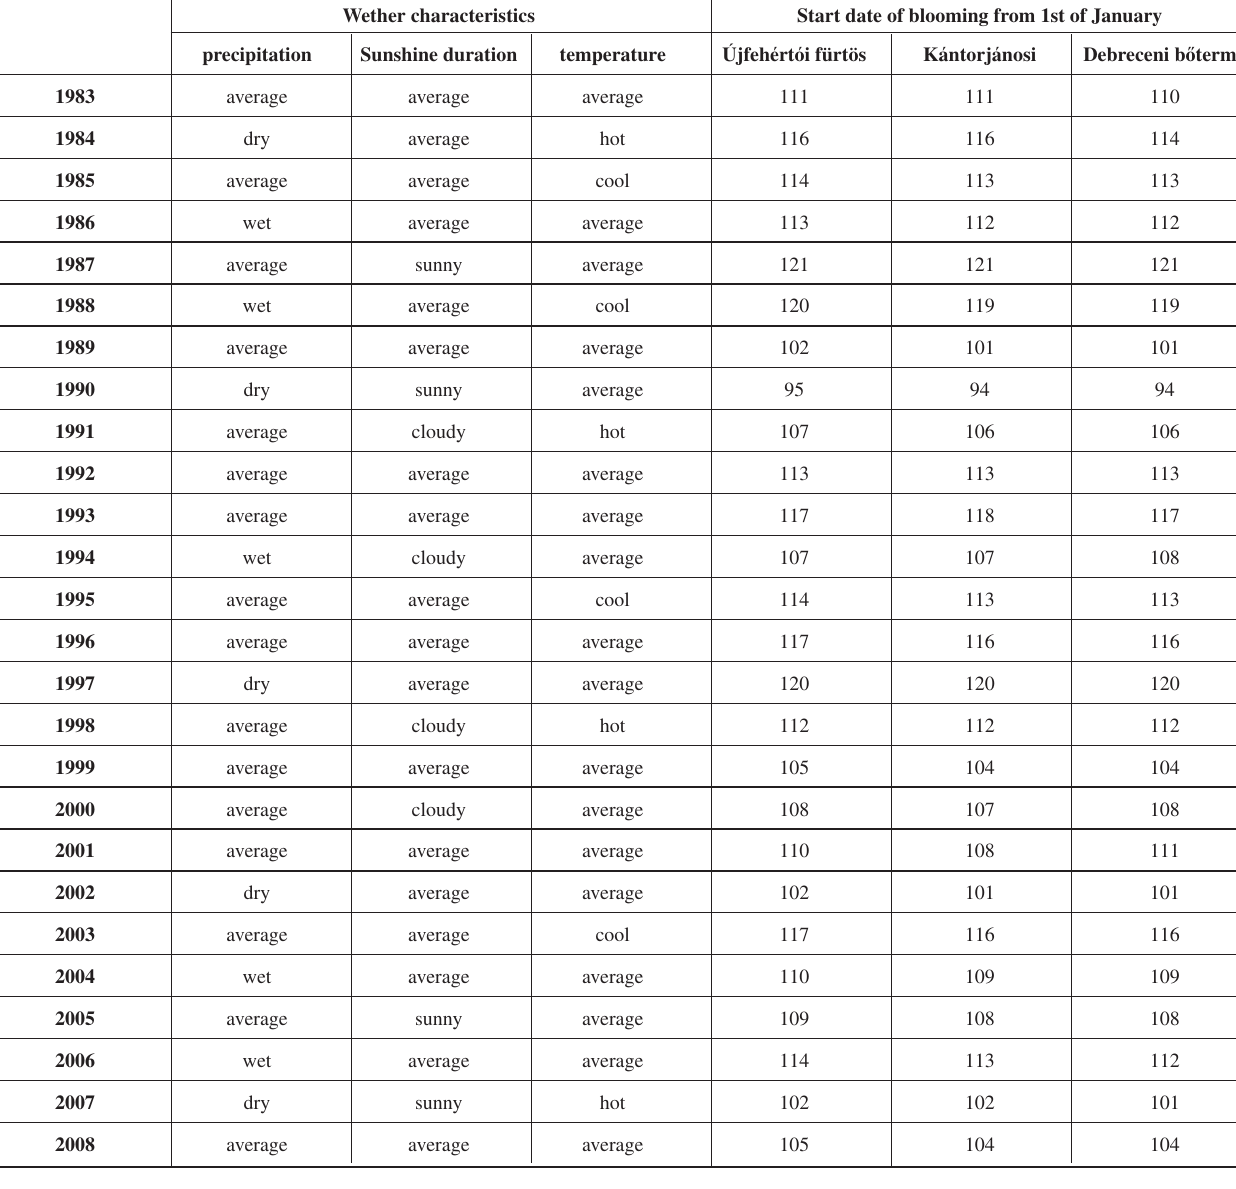
Table 1. Weather characteristics and start date of blooming at the three sour cherry cultivars Wether